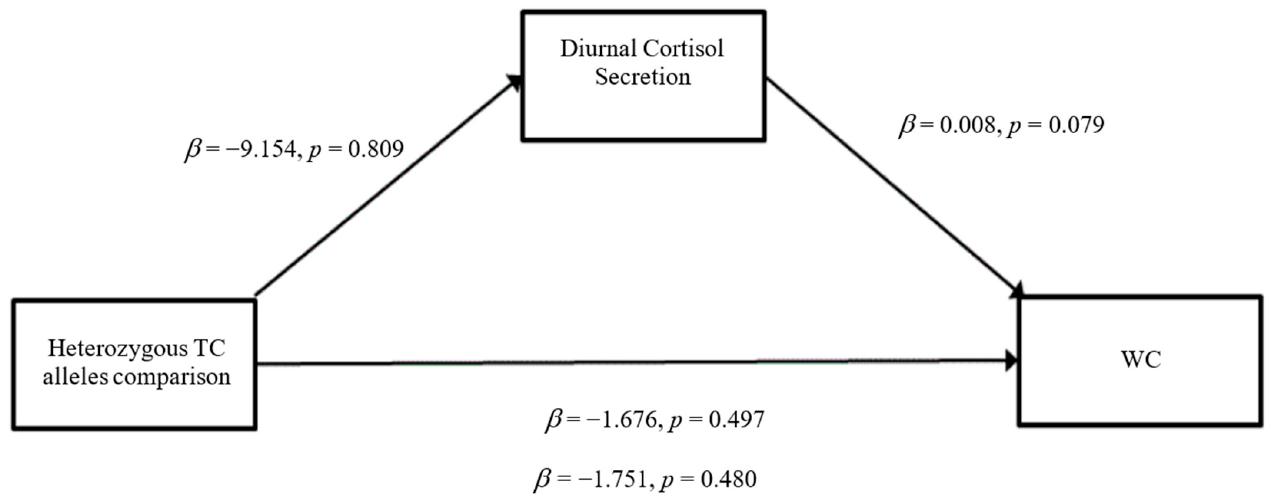
Figure 5. Mediation model for Heterozygous TC alleles comparison with WC through the pathway of diurnal cortisol secretion (Model 4).